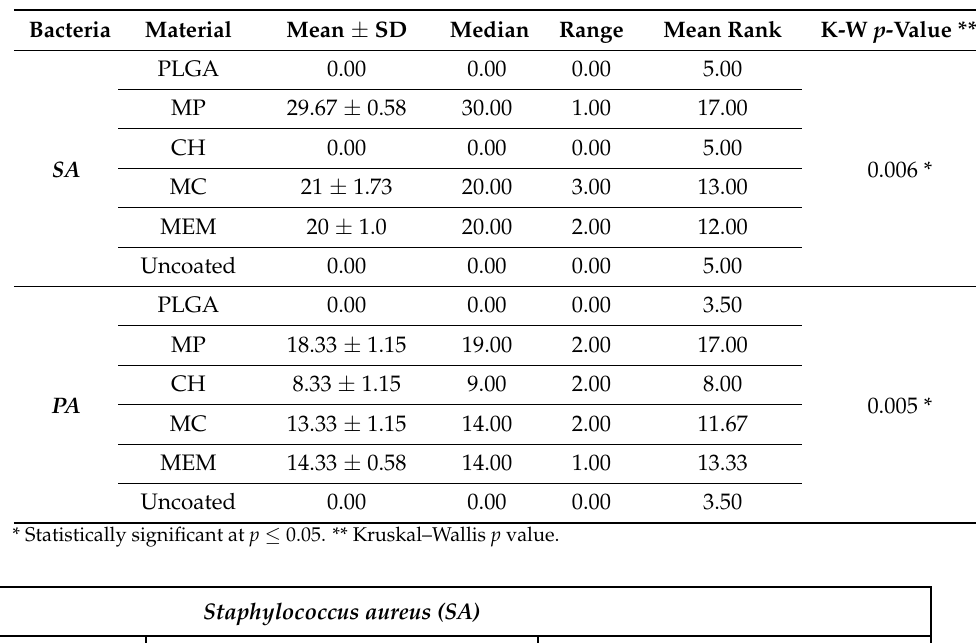
Table 1. Zone of inhibition among the different materials for SA and PA .